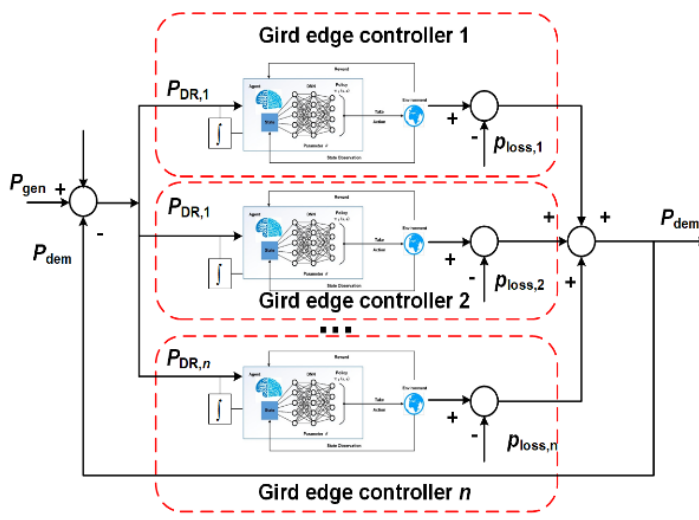
Figure 4. Grid edge controller schematic diagram.